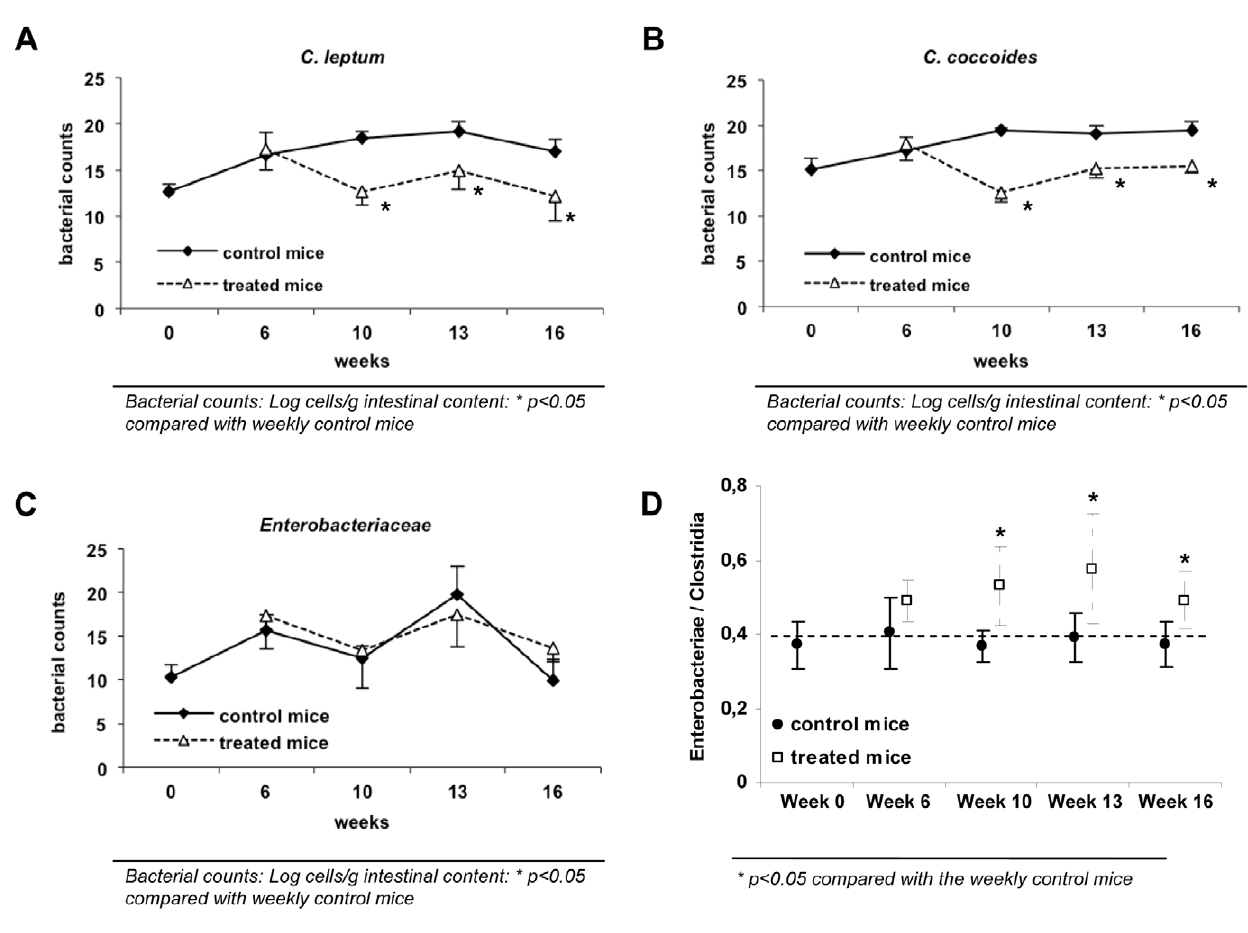
Figure 2. Temporal evolution of Clostridium groups and Enterobacteriaceae counts and their ratio in control and CCl 4 -treated mice. (A, B, C) Bacterial counts from samples of cecum content were measured by quantitative real-time PCR and represented as Log cell/g intestinal content. Values shown as mean 6 standard deviation are represented for control (n=4/week) and treated mice (n=6/week) along the 16 weeks of study. (D) Differences in the Enterobacteriaceae/Clostridia ratio are represented as mean 6 standard deviation for control (n=4/week) and treated mice (n=6/ week) along the 16 weeks of study. doi:10.1371/journal.pone.0023037.g002 PLoS ONE |